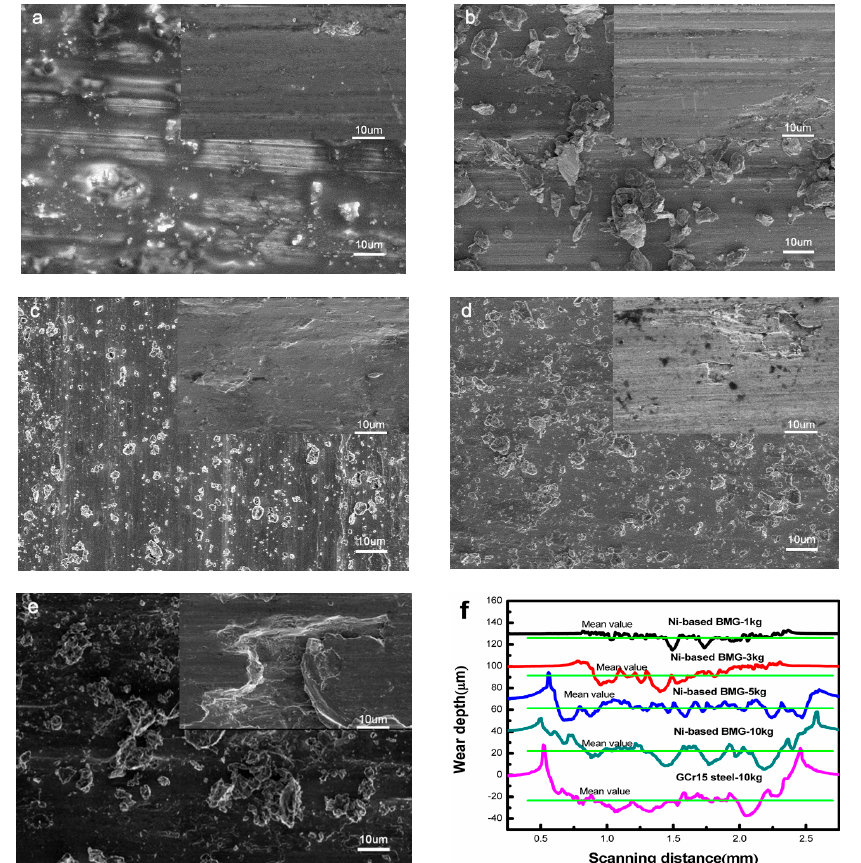
Figure 4. The SEM images of the surfaces of as-worn brass plates at a speed of 5 mm/s and a sliding time of 100 min, with the inset demonstrating the SEM images for the cleaned worn surfaces of the corresponding samples: ( a – d ) the surfaces of the brass plates against Ni-based pins under different loads of 1 kg, 3 kg, 5 kg, 10 kg, respectively; ( e ) the surface of the brass plates against GCr15 steel under 10 kg; ( f ) the cross-section wear tracks of the cleaned worn surfaces of the brass plate under different normal